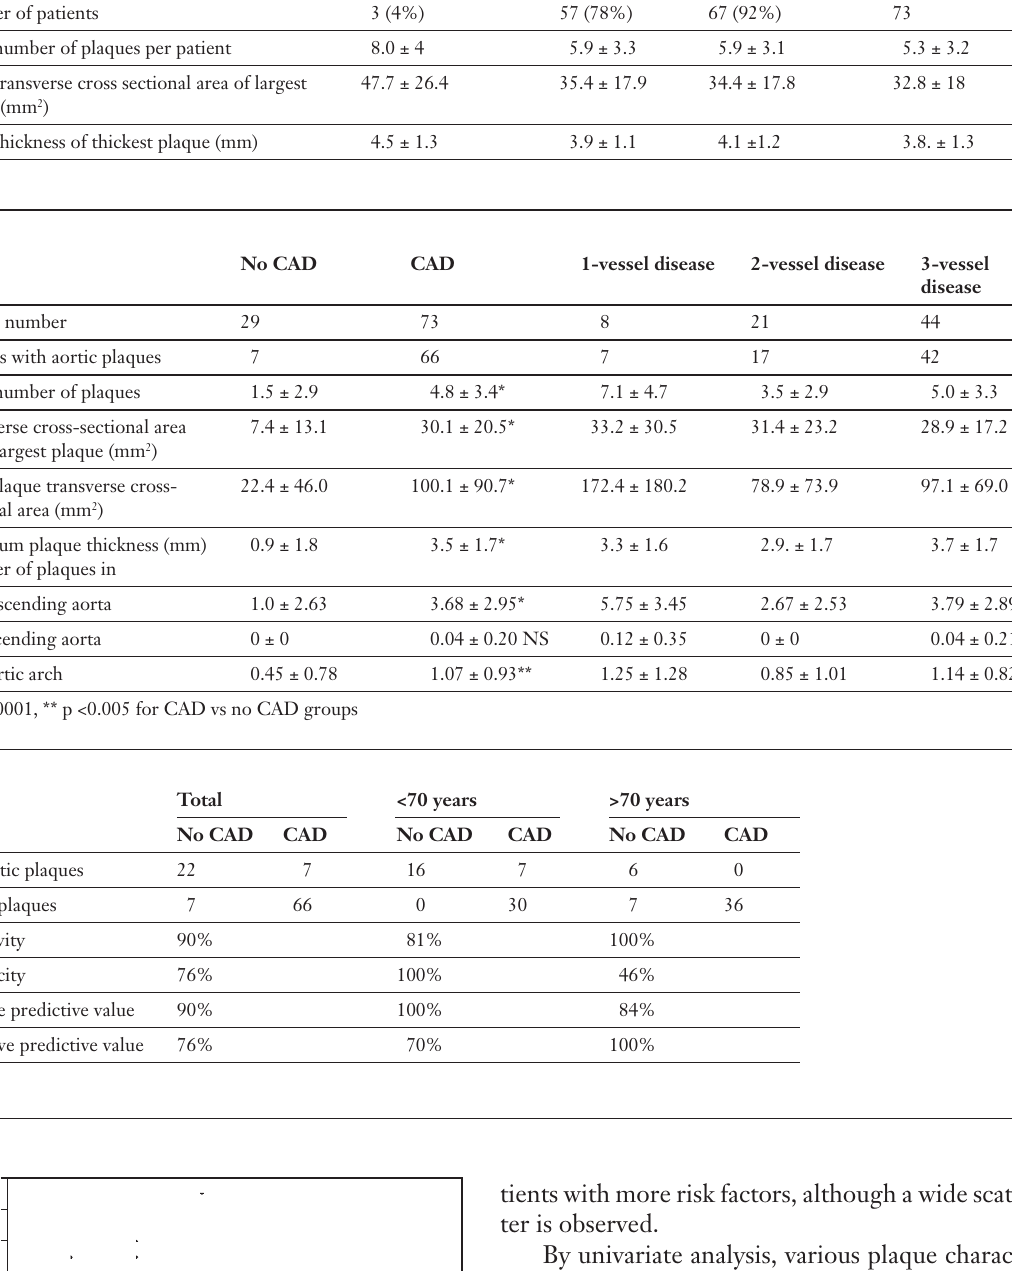
Number of plaques in the thoracic aorta in relation to the num- ber of risk factors for the whole popula- tion. The regression line (solid line) is shown with the 95% confidence interval (dotted lines).